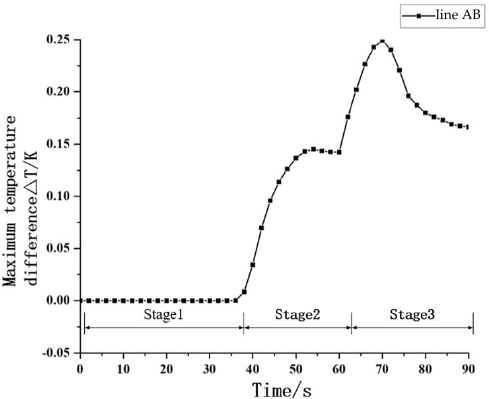
Figure 20. The curve of maximum difference Δ T on line AB with time.